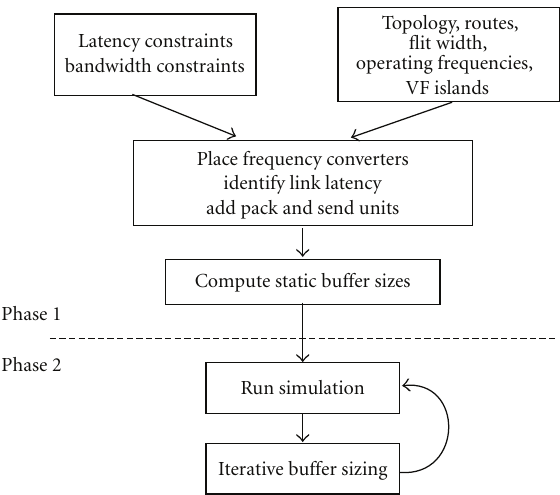
Figure 2: Bu ff er sizing design